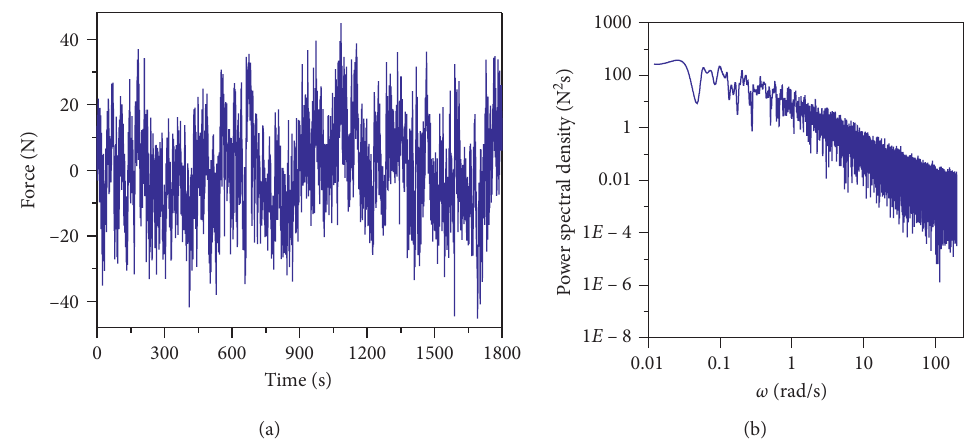
Figure 9: Buffeting force loading curve and pulse power spectrum.